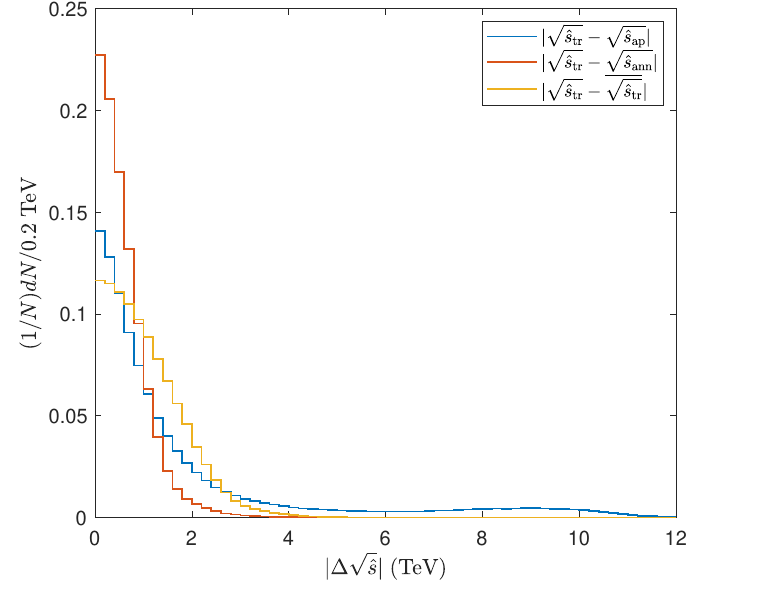
√ √ ˆ s | for ˆ s , ˆ s ap and ˆ s ann